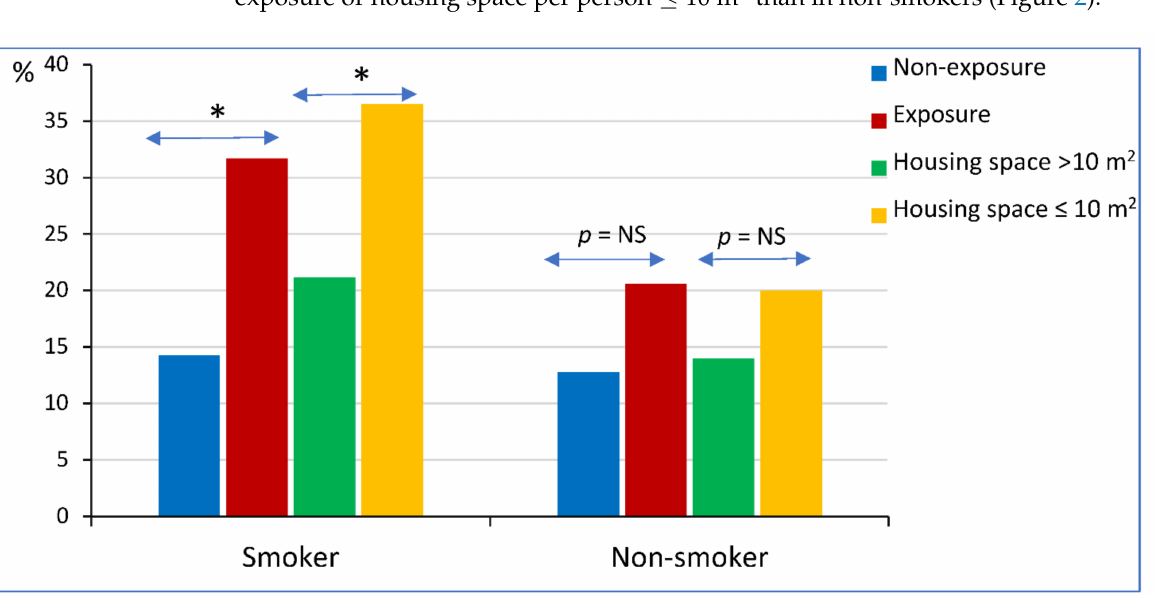
Figure 2. Comparison of the risk of exacerbations in relation to occupational exposure and housing space, among smokers and non-smokers patients. * χ 2 test, p ≤ 0.05; NS: Non